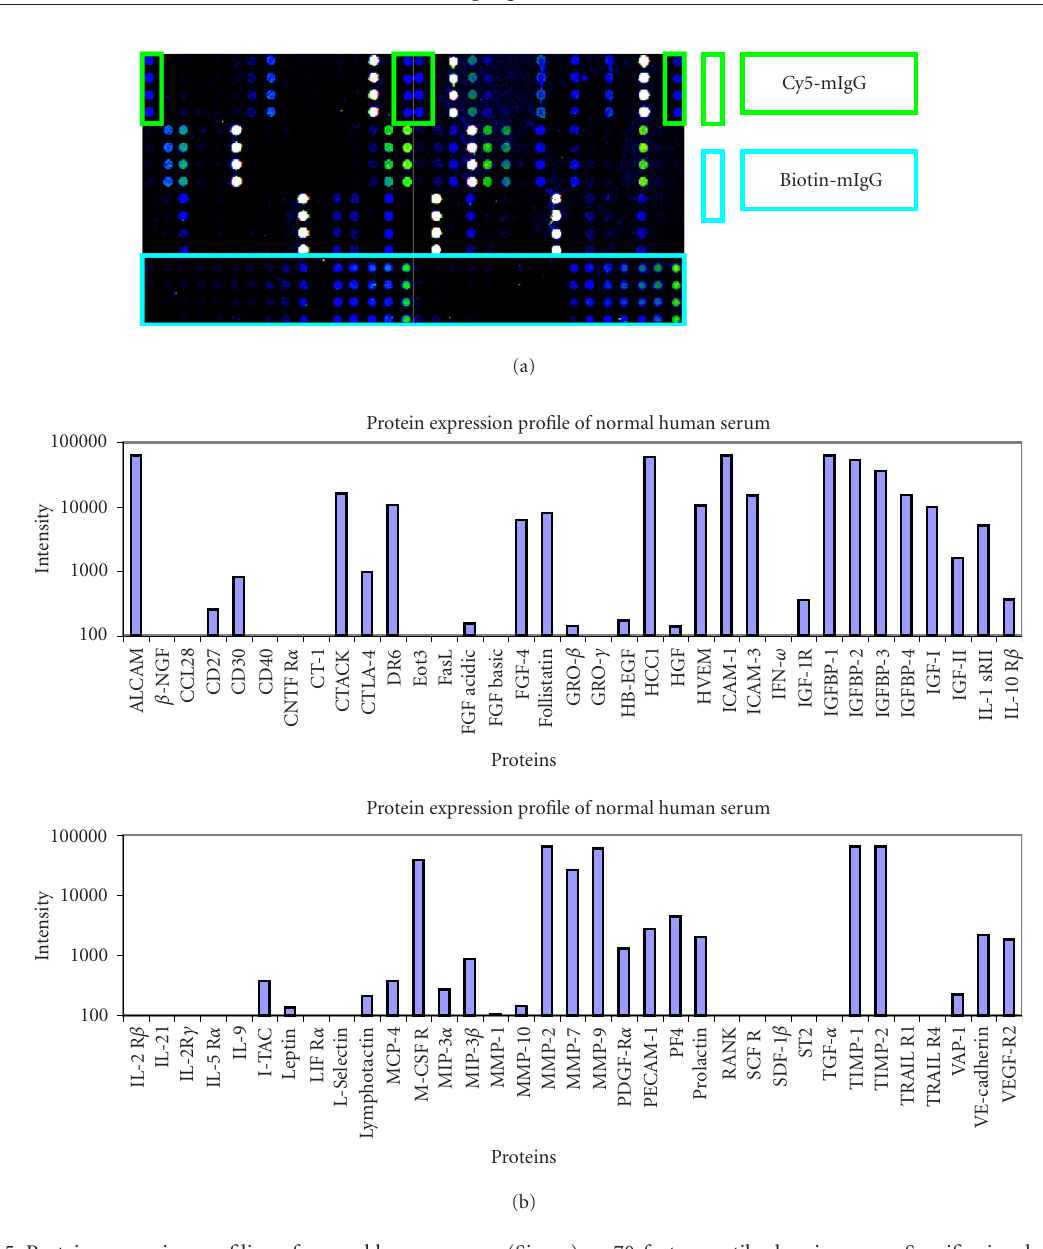
capture antibodies and antigens or detection antibodies for 150 features were determined in three di ff erent